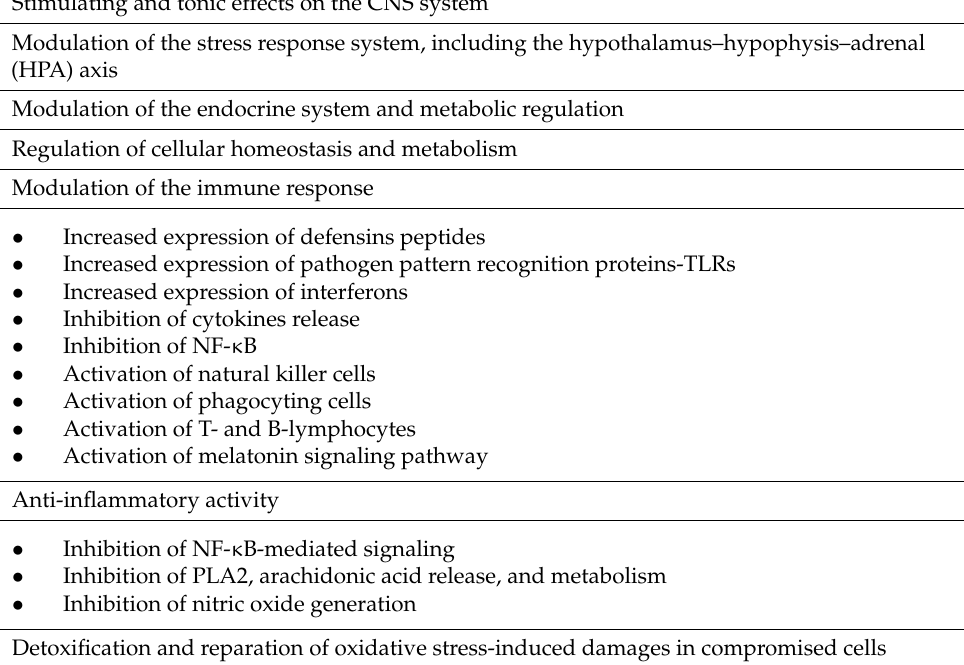
Figure 4. The rationale of specific and nonspecific pleiotropic actions of adaptogens. Table 1. Pharmacological activities of adaptogens. Adapted from [6,9,13,113]. Stimulating and tonic effects on the CNS